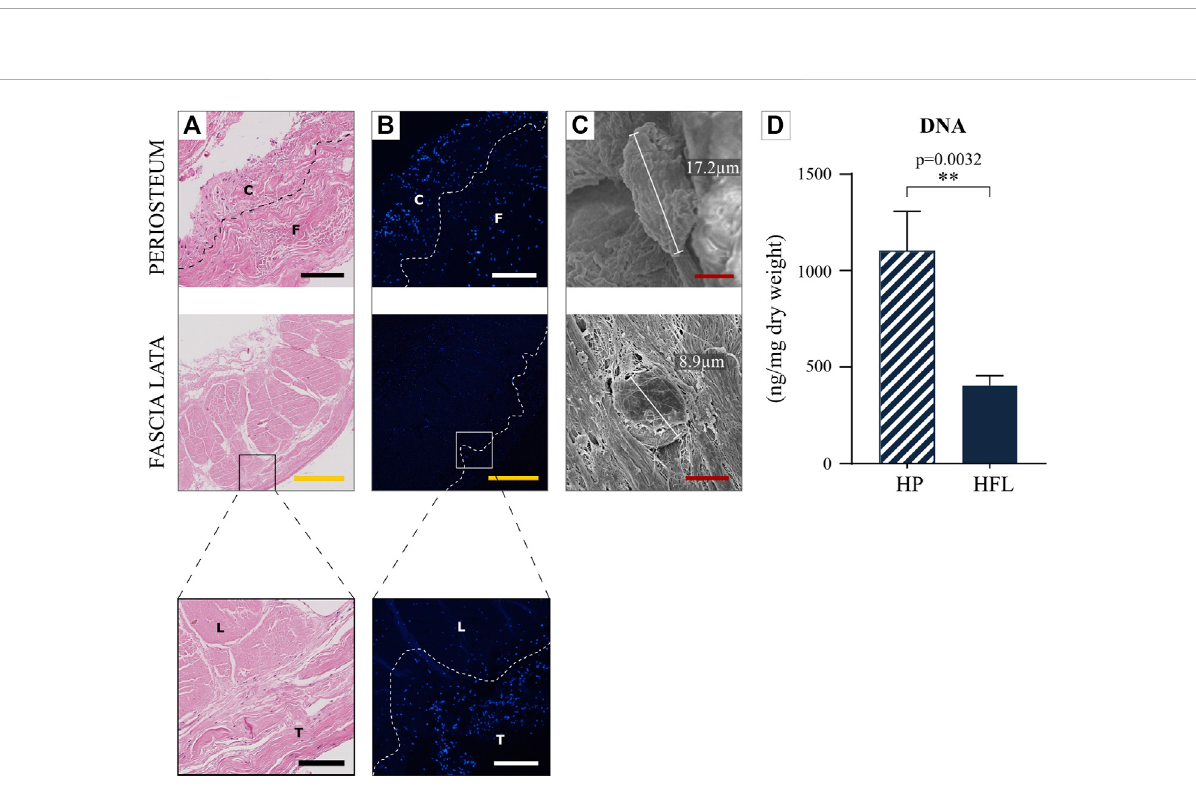
FIGURE 6 Comparison of the HP and HFL by hematoxylin and eosin staining (A) , by fl uorescent cytochemistry (Hoechst) (B) (including zoom in), by electronmicroscopy (C) aswellasDNAquanti fi cation( N =4donorsxthreesamplesfromeachdonorleadingto n =12specimensanalyzedforeach tissue) (D) .C:cambiallayer,F: fi brouslayer,L:longitudinallayer,T:transverselayer,HP:humanperiosteum,HFL:humanfascialata.White/blackscale bars: 100 µm. Yellow scale bars: 500 µm. Red scale bars: 5